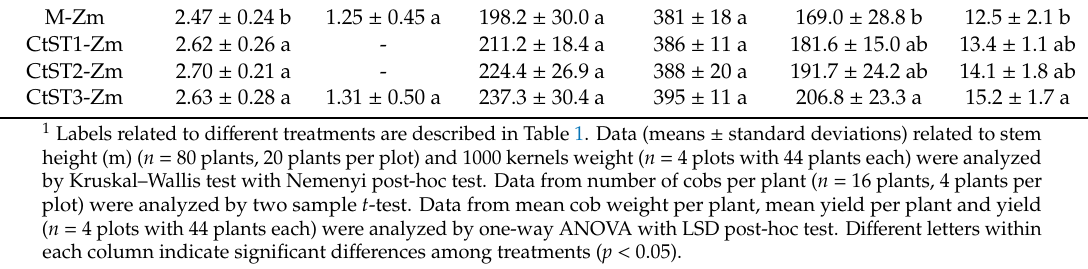
Table 4. E ff ect of Ct0861 in plant growth and yield of maize grown in open field. Stem Treatments 1 Height